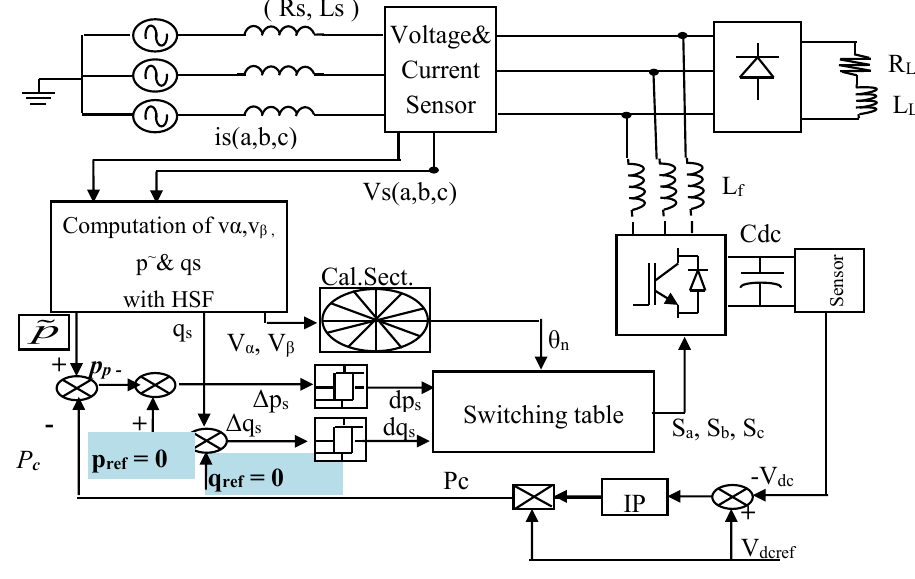
Figure 4. ZDPC Shunt Active Power Filter